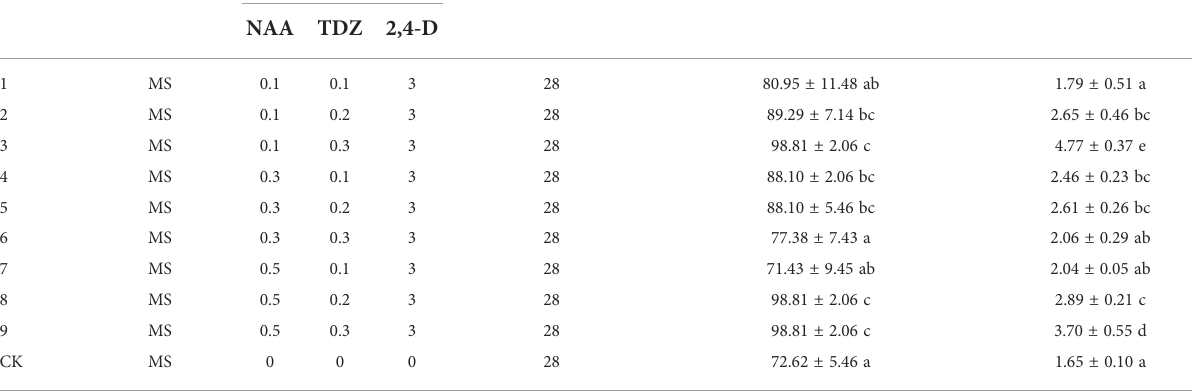
TABLE 4 Effects of different plant growth regulators on callus induction of cotyledons in 80d developmental stage. Number Basic medium plant growth regula- tor (mg·L – 1